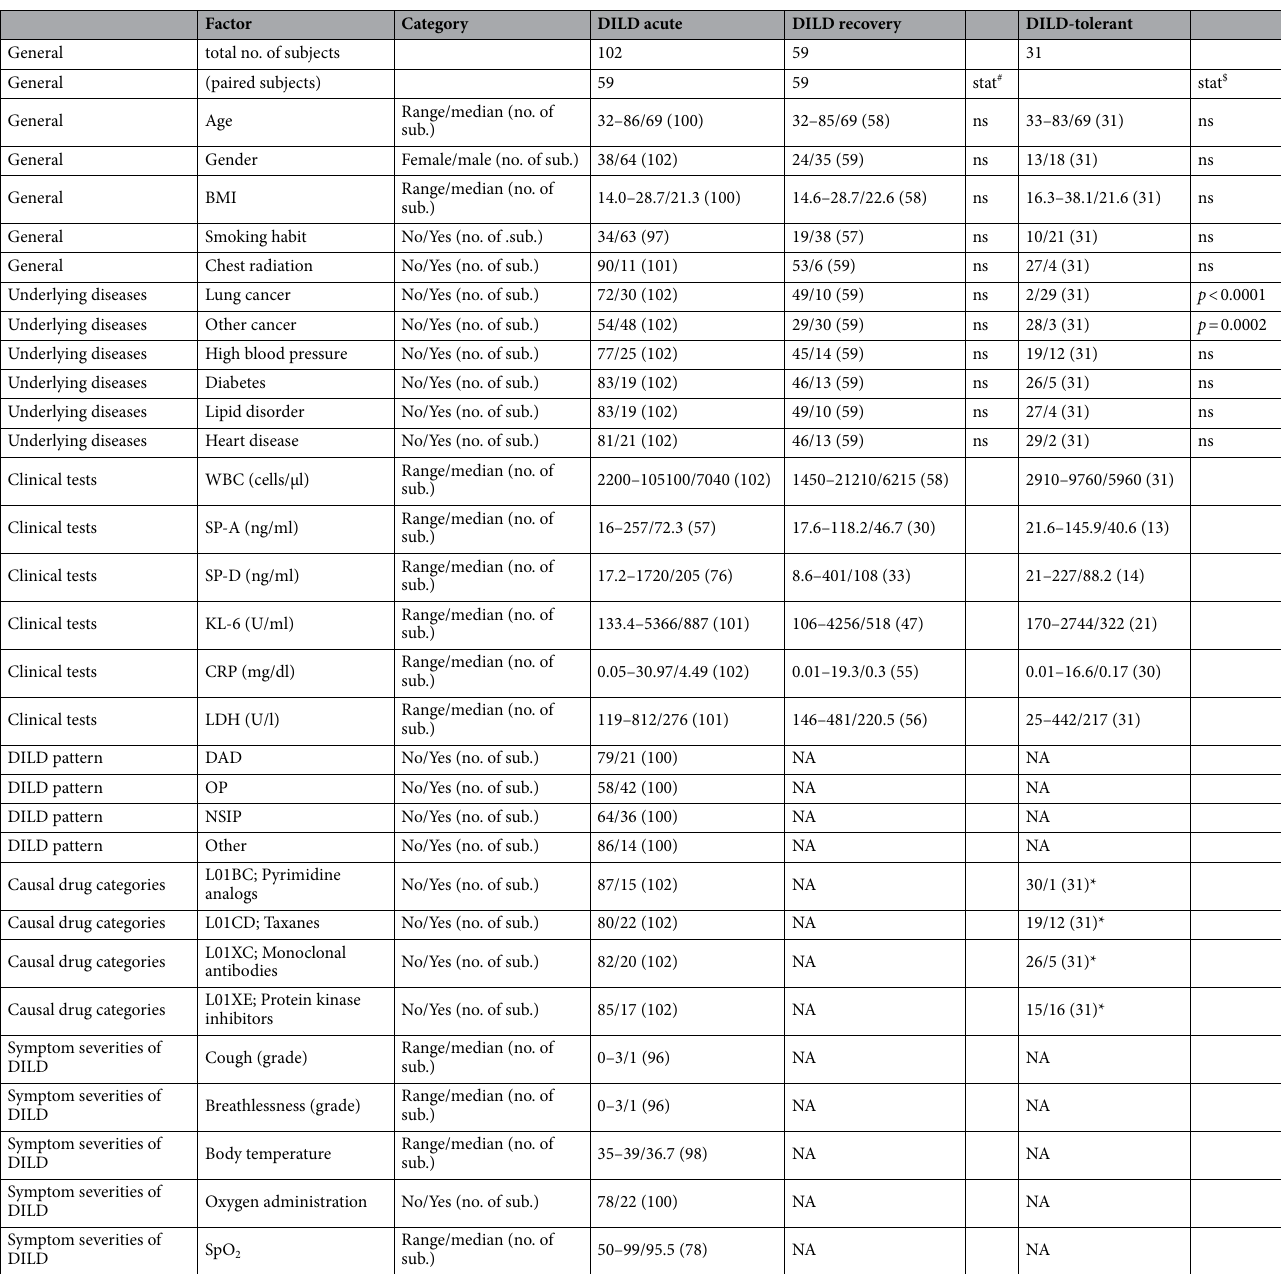
Table 1. Summary of clinical characteristics of DILD and DILD-tolerant patients used for LPC biomarker assay. *Prescribed DILD-causing drugs without DILD for at least 12 weeks, stat#: Statistical comparison between DILD acute and DILD recovery, stat$: Statistical comparison between DILD acute and